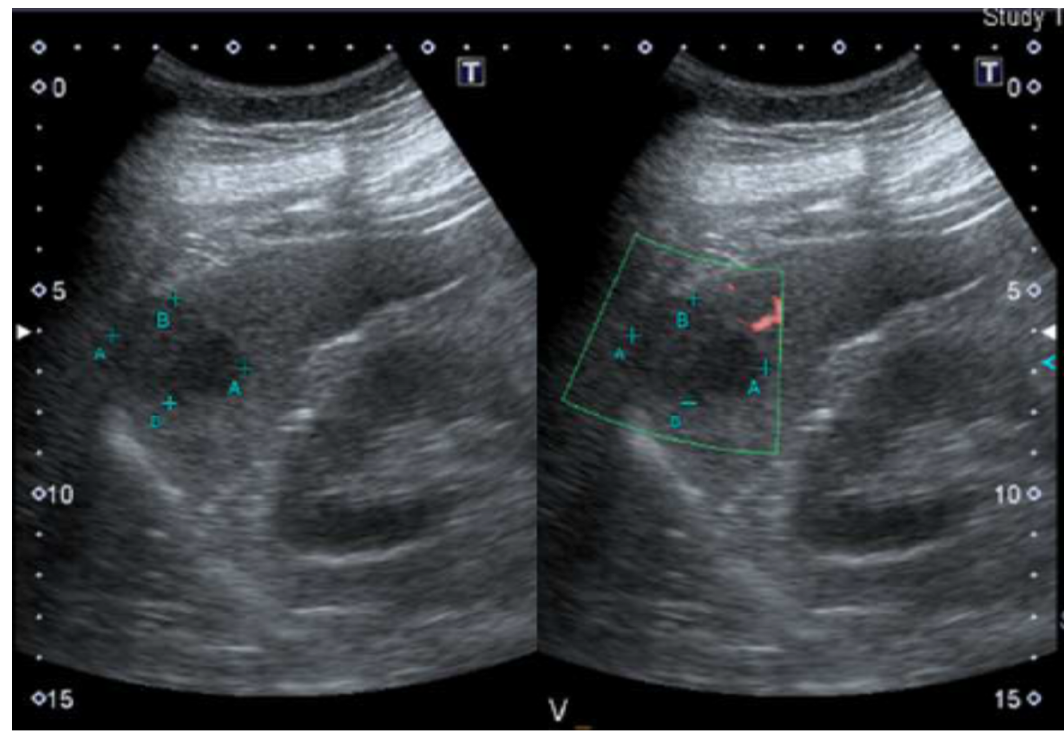
Figure 1. Abdominal ultrasound revealed a 3 cm hypoechoic splenic nodule during a routine examination 4 months earlier.